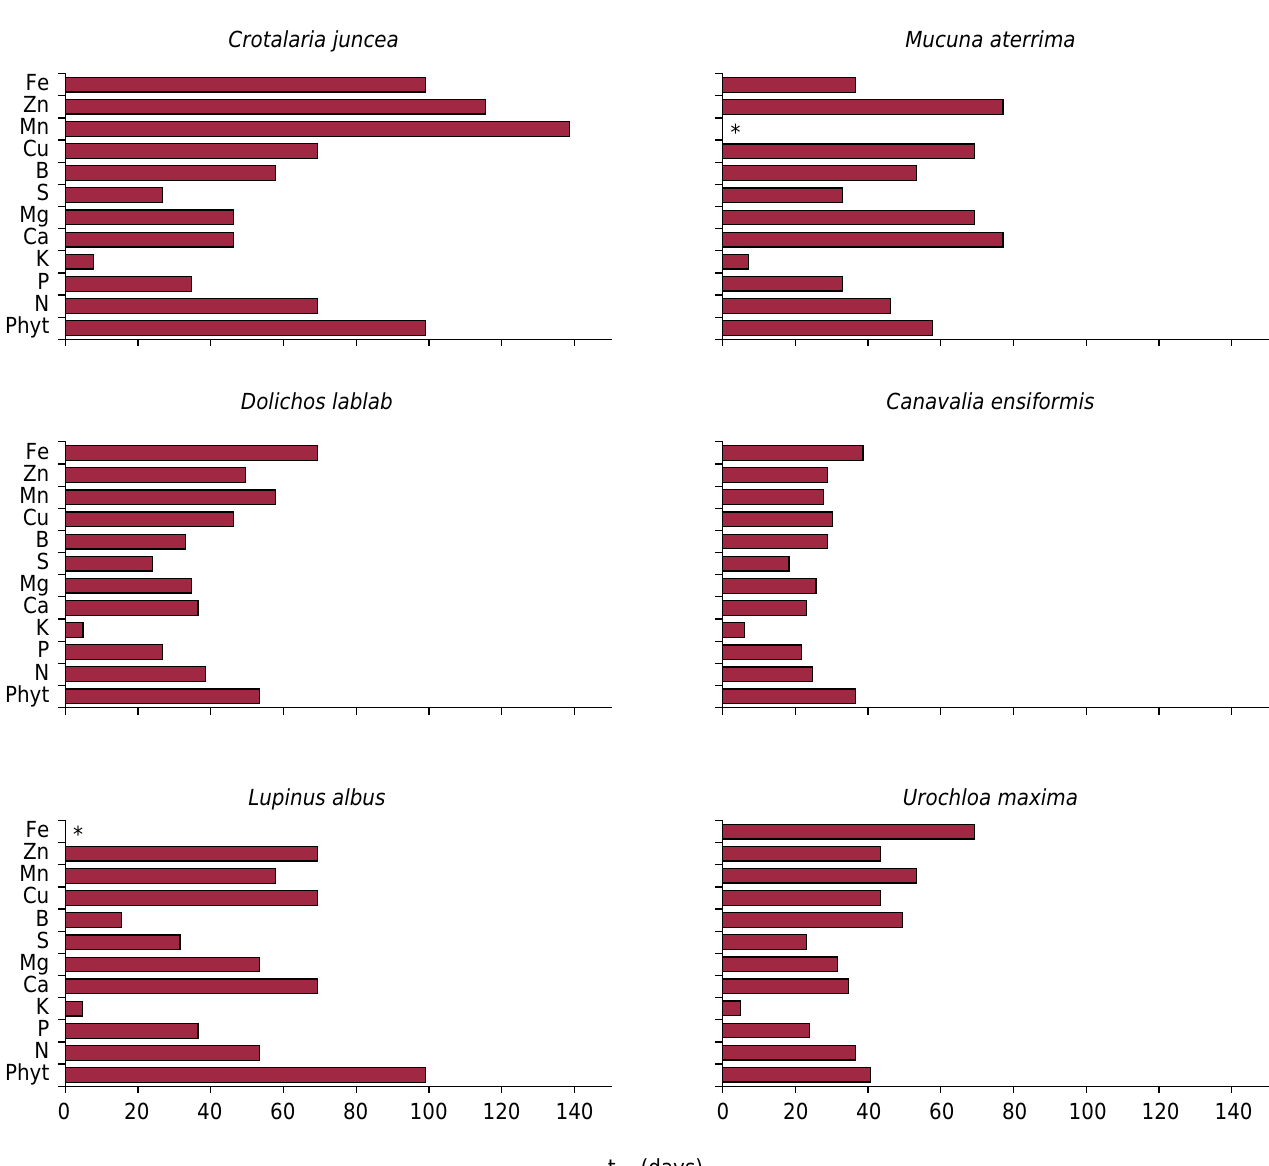
Figure 5. Half-lives (t 1/2 ) of phytomass (Phyt) and nutrients of litter from different cover crops. * : not